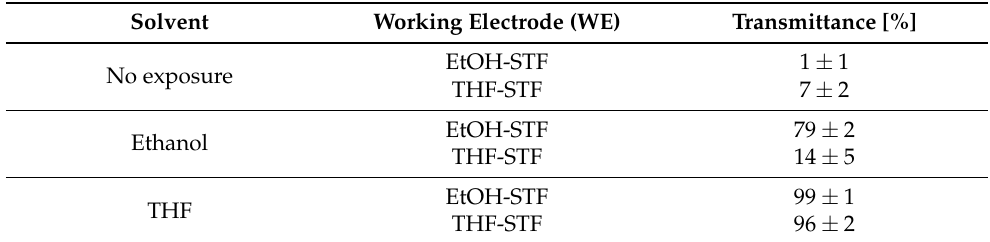
Table 3. Transmittance of thin films on glass substrates recorded at a 550 nm wavelength. The data show a response to ethanol and THF exposure, as well as the behavior of the non-exposed device. Uncertainty was determined from three